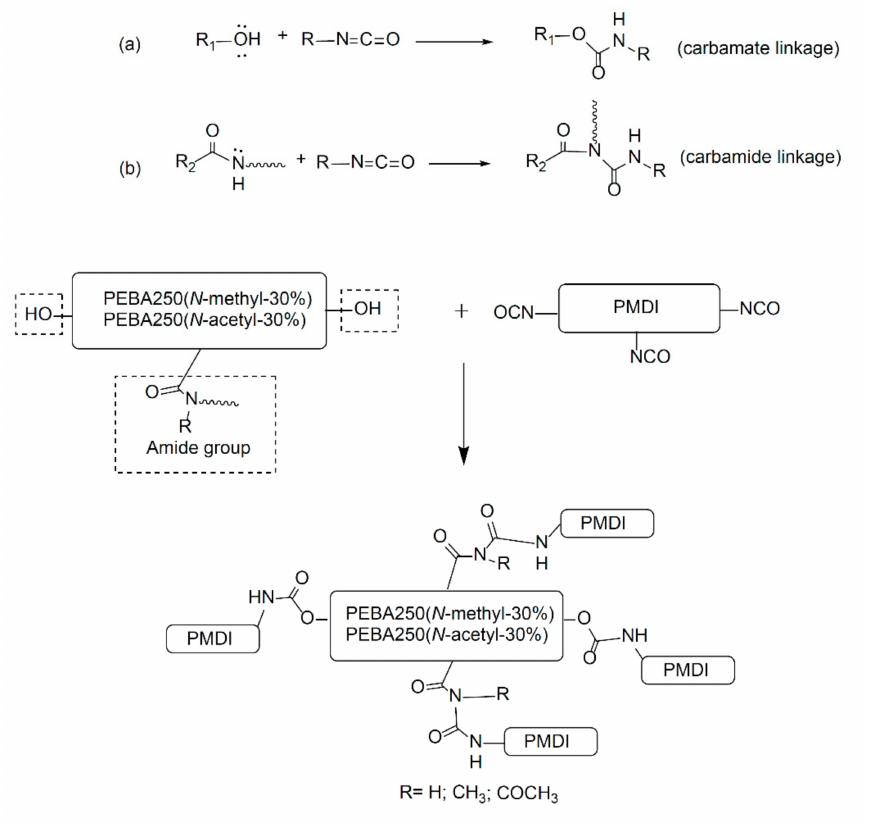
Figure 8. Cross-linking reaction of PEBA–poly(4,4 (cid:48) -methylenebis(phenyl isocyanate) (PMDI) (a) through carbamate linkage (b) through carbamide